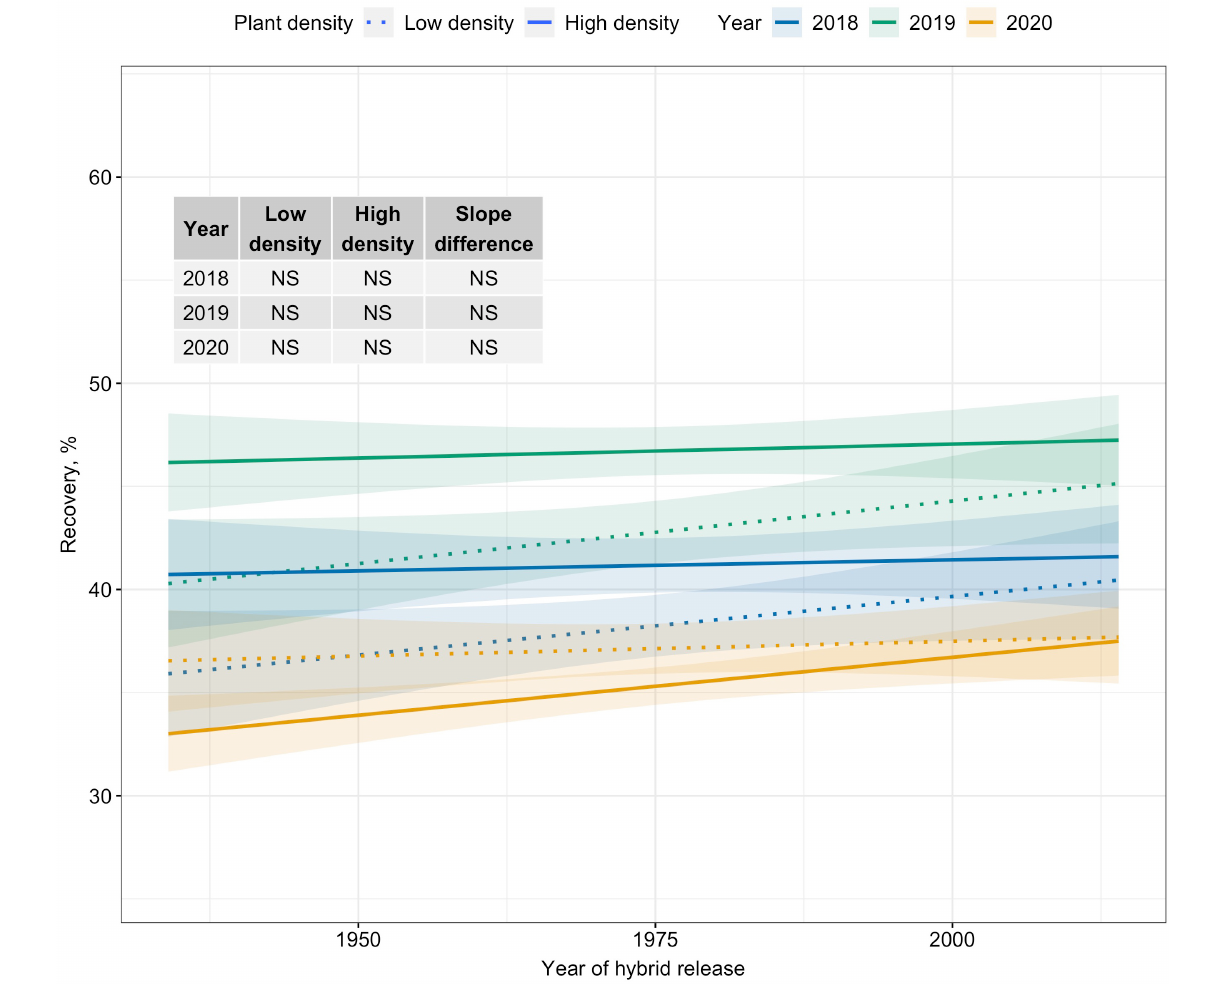
FIGURE 3 | Best fit line for relationship between year of hybrid release and recovery (%) for two levels of plant density at Urbana, IL in 2018–2020. Recovery is the percentage of green ear mass accounted by kernel mass. Ninety-five percent confidence intervals are shown by the shaded regions around the line of best fit. Slope estimates from linear regression analysis for Low plant density (9,900 plants/ha), High plant density (79,000 plants/ha), and difference between two plant densities are shown. Non-significant slope estimates are denoted by NS ( α = 0 .